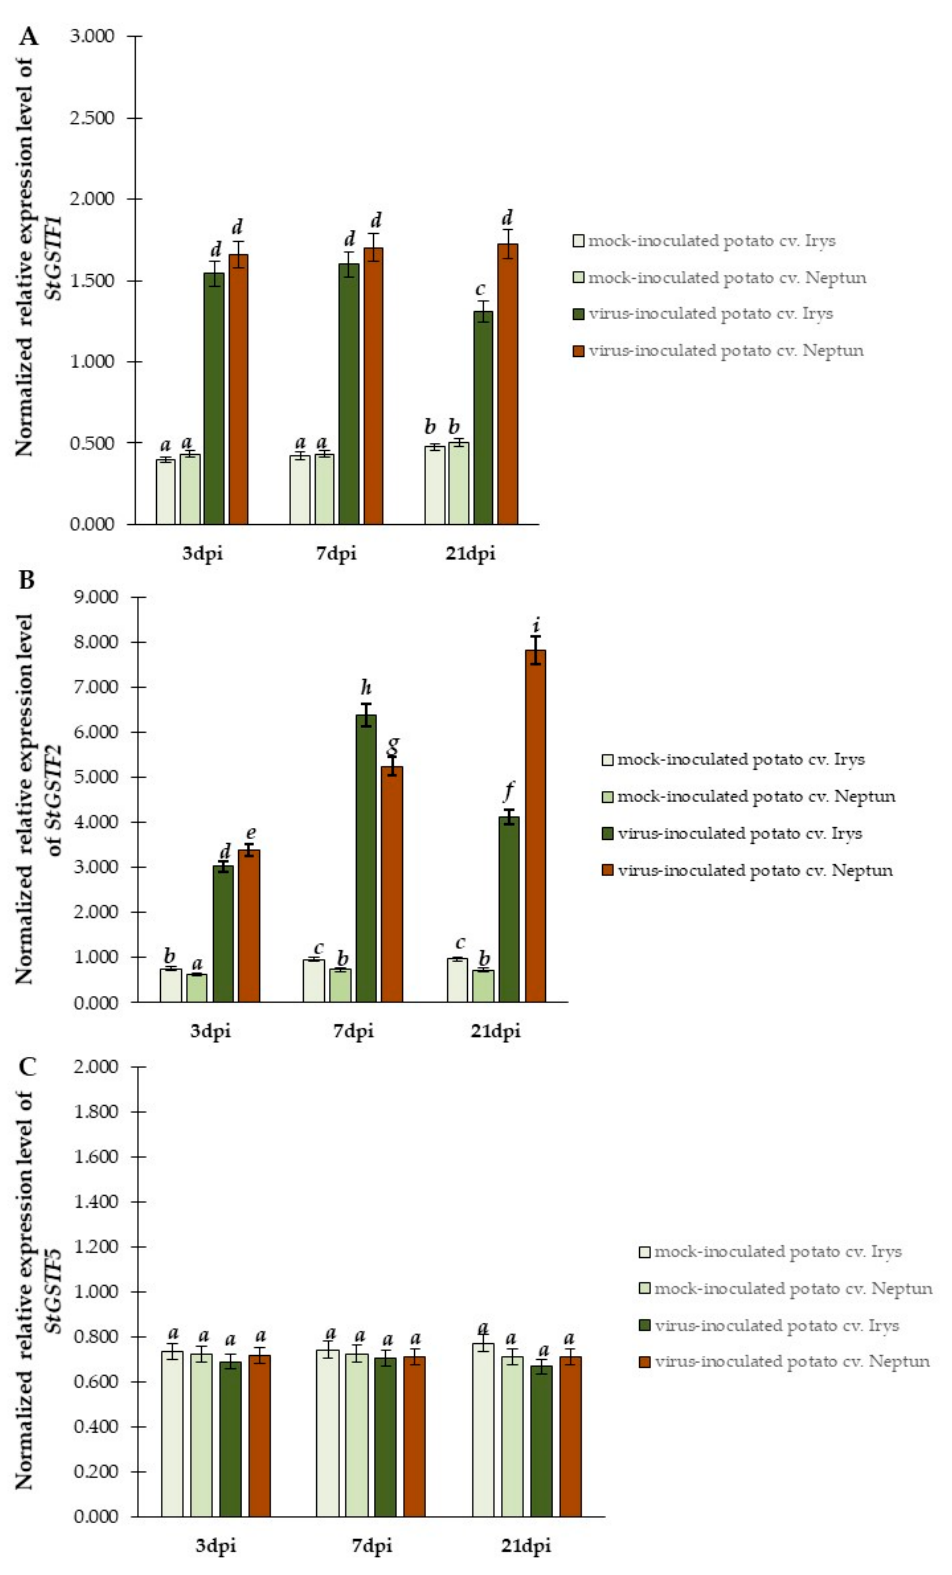
Figure 2. The normalized relative expression levels of StGSTF1 ( A ), StGSTF2 ( B ), and StGSTF5 ( C ) calculated based on mean expression of StEf1 α and StSec3 reference genes in mock- and virus- inoculated Irys and Neptun cultivars between 3 and 21 dpi. Using ANOVA and Tukey’s HSD test, the mean values of normalized expression levels were calculated at p < 0.05. The statistically significant values are marked by letters above the bar.